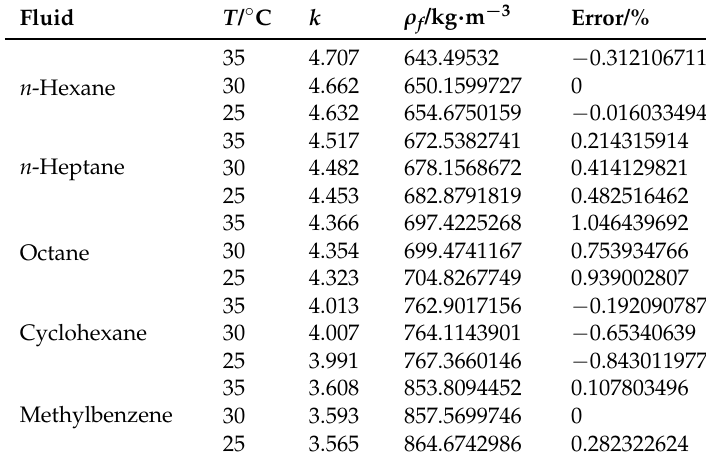
Table 2. The density measurement results by the slope method under free end excitation.